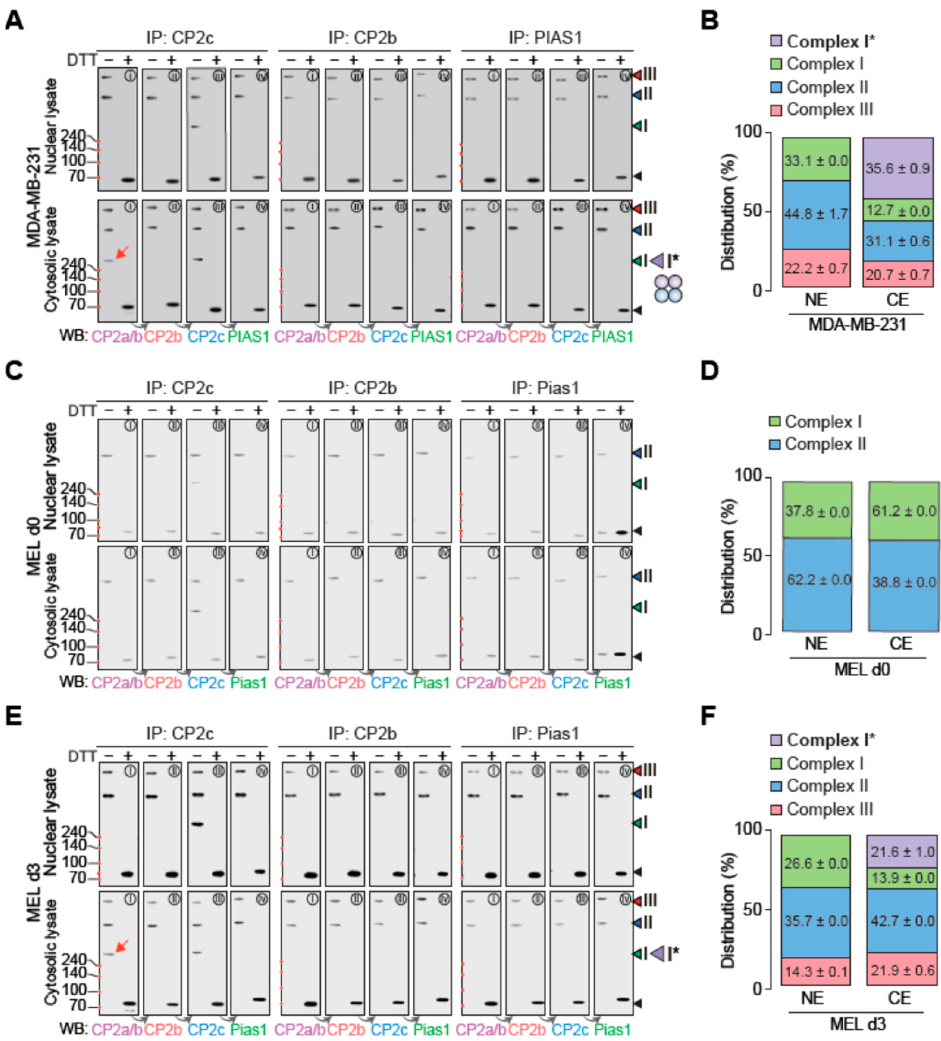
Figure 5. Cytosolic CP2a regulates the subcellular distribution and dynamics of various CP2c complexes. ( A , B ) CP2c complex types and subcellular distribution of each complex in MDA-MB-231 cells by DSP crosslinking and sequential Western blot. ( A ) Immunoblots showing various nuclear (top) and cytosolic (bottom) CP2c complexes. ( B ) Estimated fractions of each CP2c complex type in the nucleus and cytosol. ( C – F ) Subcellular distribution and dynamics of various CP2c complexes in HMBA-induced differentiating MEL cells in vitro. Immunoblots showing various nuclear (top) and cytosolic (bottom) CP2c complexes in d0 ( C ) and d3 ( E ) MEL cells. Estimated fractions of each CP2c complex type are shown in the nucleus and cytosol in d0 ( D ) and d3 ( F ) MEL cells. Samples were subjected to 10% SDS-PAGE. Red arrows in the immunoblots highlight the existence of CP2a in the cytosol-specific CP2c complex, complex I* ([C2A2]). Note, that to evaluate the ratios of